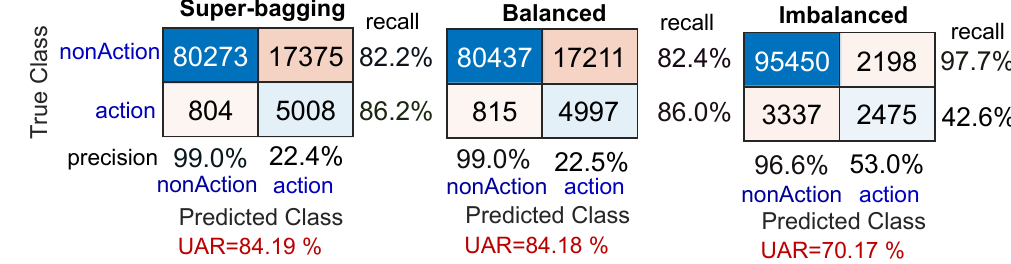
Figure 5. Dominant Hand: Confusion Matrices for tree bagger classifier for all learning methods i.e., balanced, imbalanced and super-bagging methods.